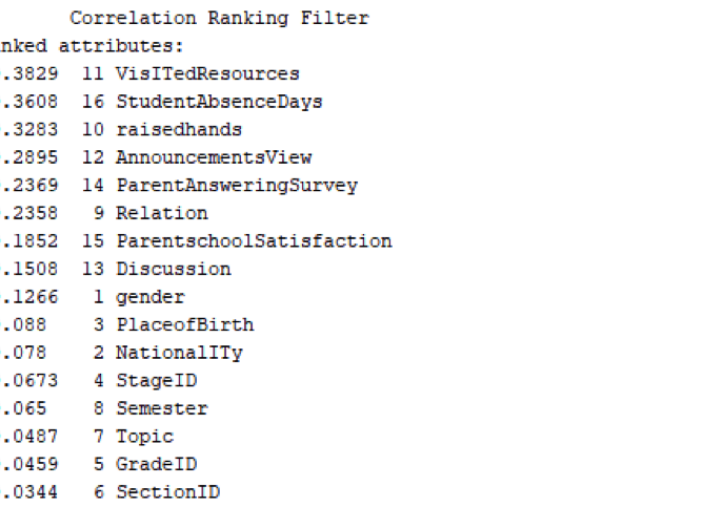
Figure 5. Correlation